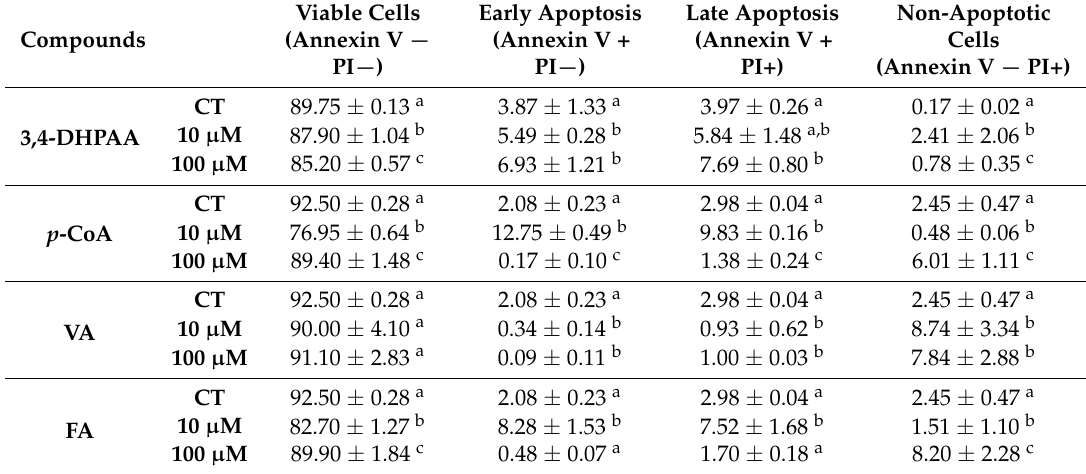
Table 2. Effect of 3,4-DHPAA, p-CoA, VA e FA (10.0 µM and 100.0 µM) on stages of death process in human colon adenocarcinoma cells (HT-29) after 24 h.